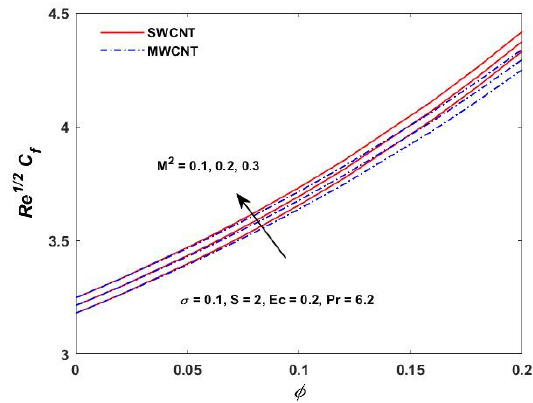
Figure 17. 𝑀 (cid:2870) verses 𝑅𝑒 (cid:2869)/(cid:2870) 𝐶 (cid:3033) .